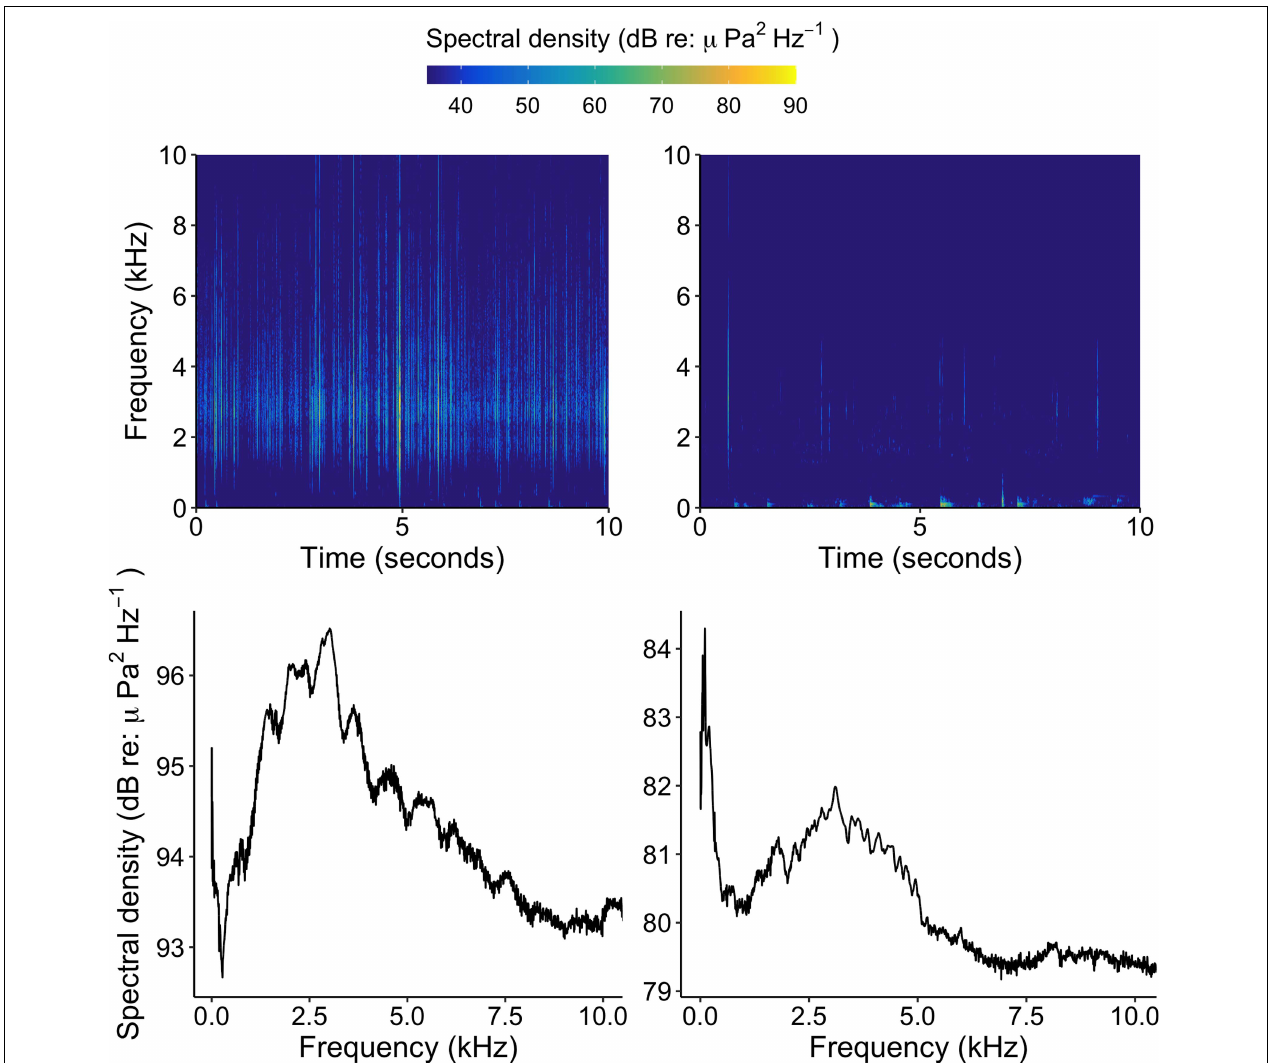
FIGURE 3 | Spectrograms (top panels) and power spectral densities (bottom panels) of healthy hardbottom soundscapes (left panels) and degraded hardbottom soundscapes (right panels) during new moon. Note the y-scale difference between lower left and lower right